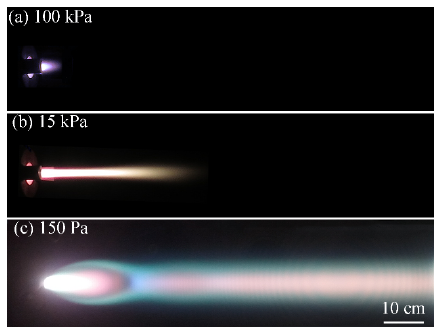
Fig. 71 YSZ powder for PS-PVD. Reproduced with permission from Ref. [407], © Elsevier B.V. 2015.